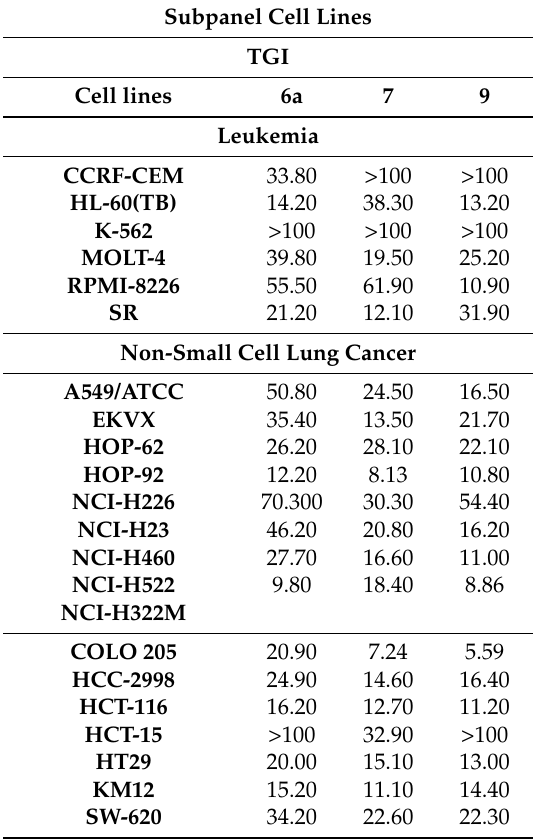
Table 3. TGI ( µ M) of five-dose screening results of compounds 6a , 7 and 9